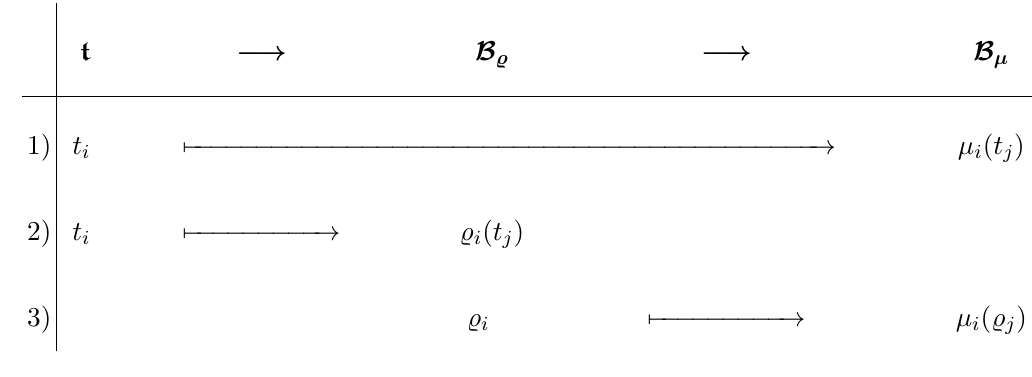
Figure 1 . Three possible base changes: 1) from t to B µ = t / W , 2) from t to B ρ = t / W 0 , 3) from B ρ = t / W 0 to B µ = t / W